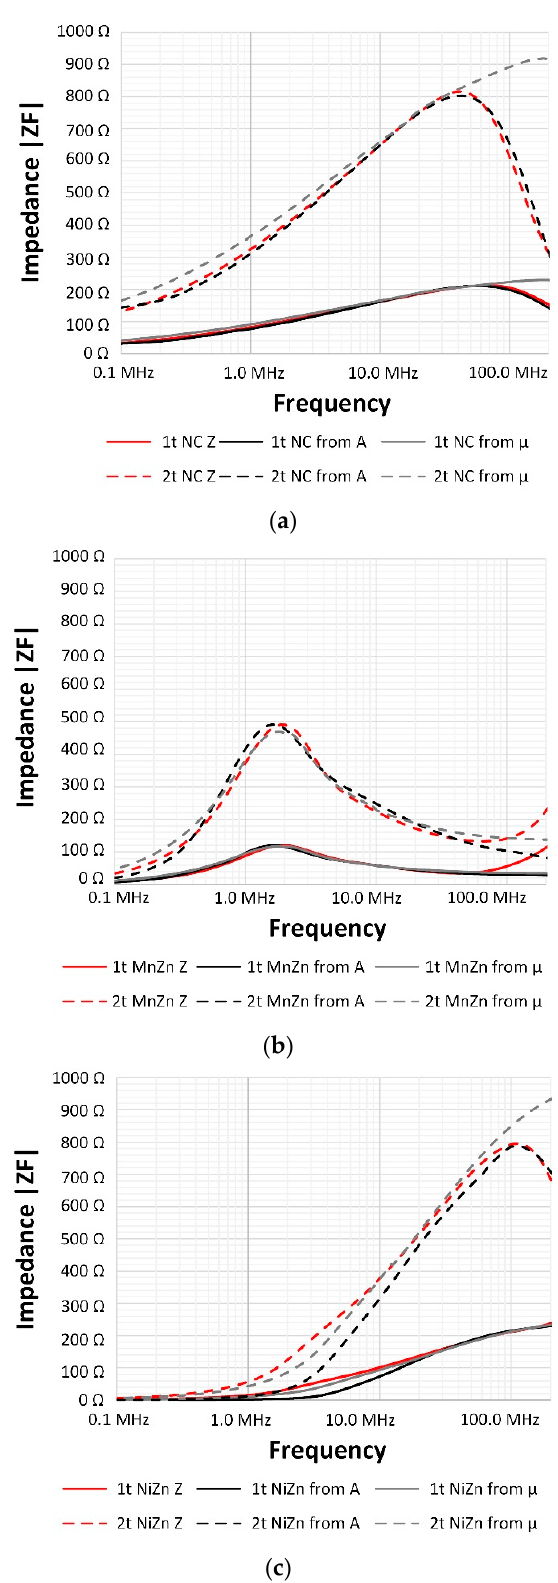
Figure 12. Comparison of the impedance obtained from three different procedures considering one and two turns wound around the sleeve ferrite core: measuring it directly, mathematically from the relative permeability and extracted from the experimental insertion loss. ( a ) NC sleeve ferrite core; ( b ) MnZn sleeve ferrite core; and, ( c ) NiZn sleeve ferrite core.